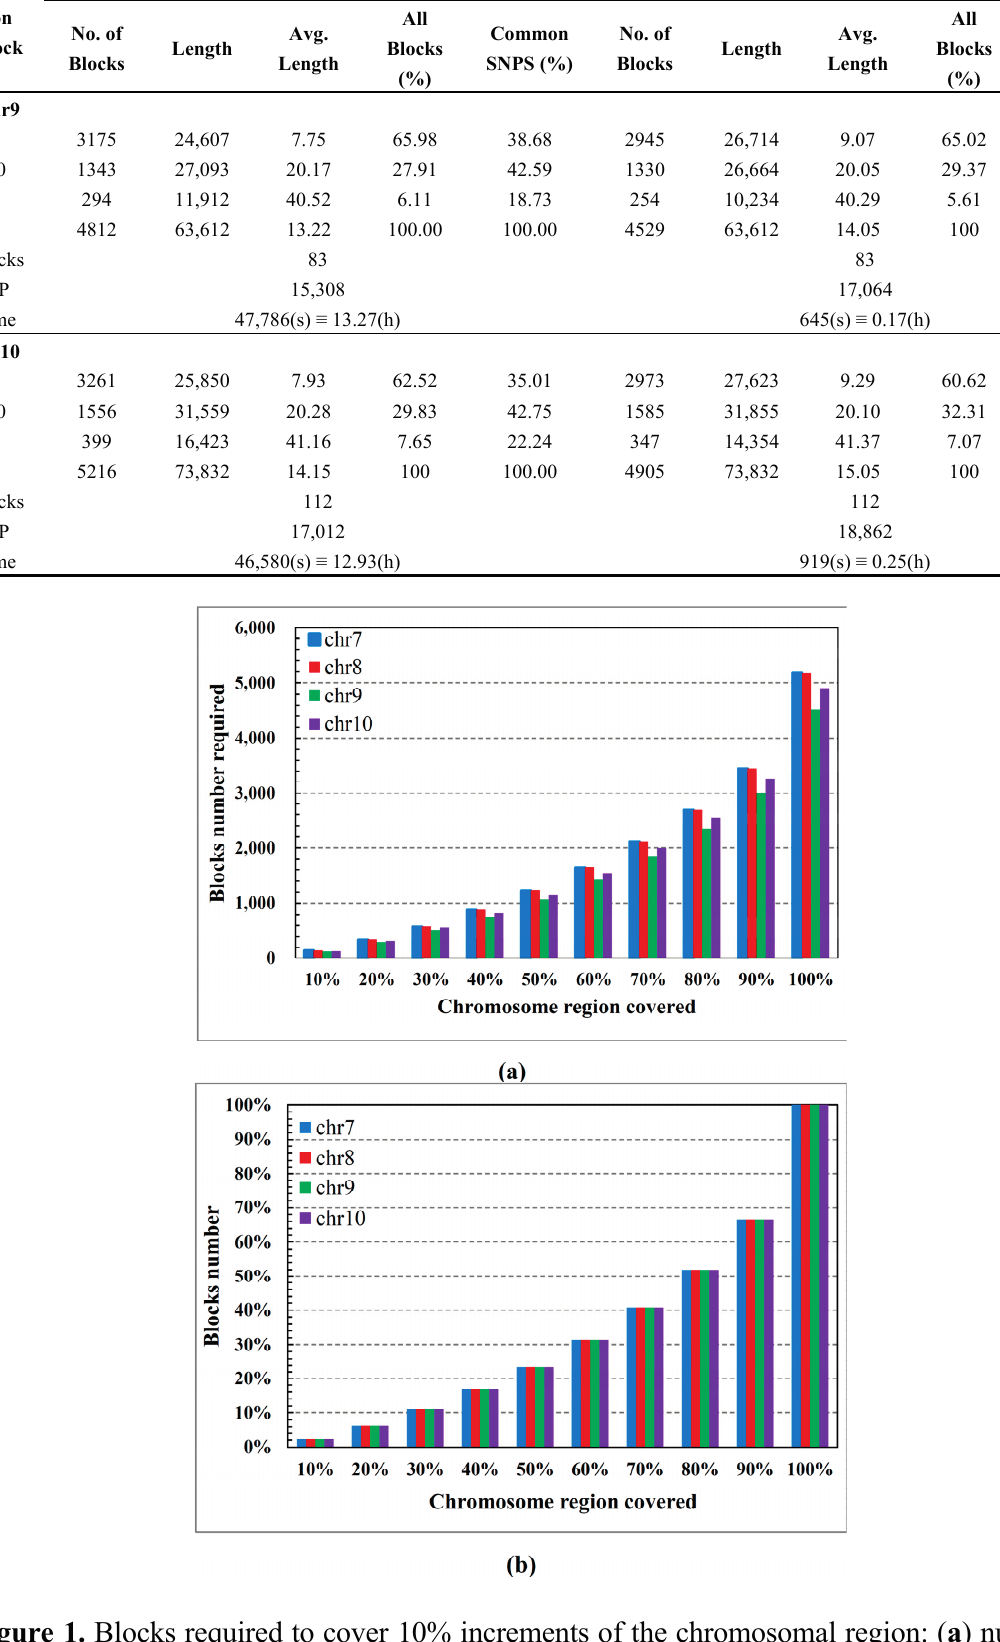
Figure 1. Blocks required to cover 10% increments of the chromosomal region: ( a ) number of blocks and ( b ) percentage of